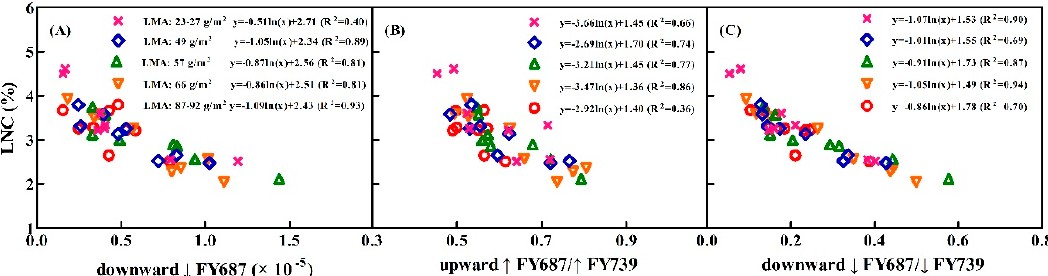
Figure 11. Effects of varied LMA on SIF yield indices to LNC. ( A ) ↓ FY687 (×10 − 5 ); ( B ) ↑ FY687/ ↑ FY739; ( C ) ↓ FY687/ ↓ FY739.